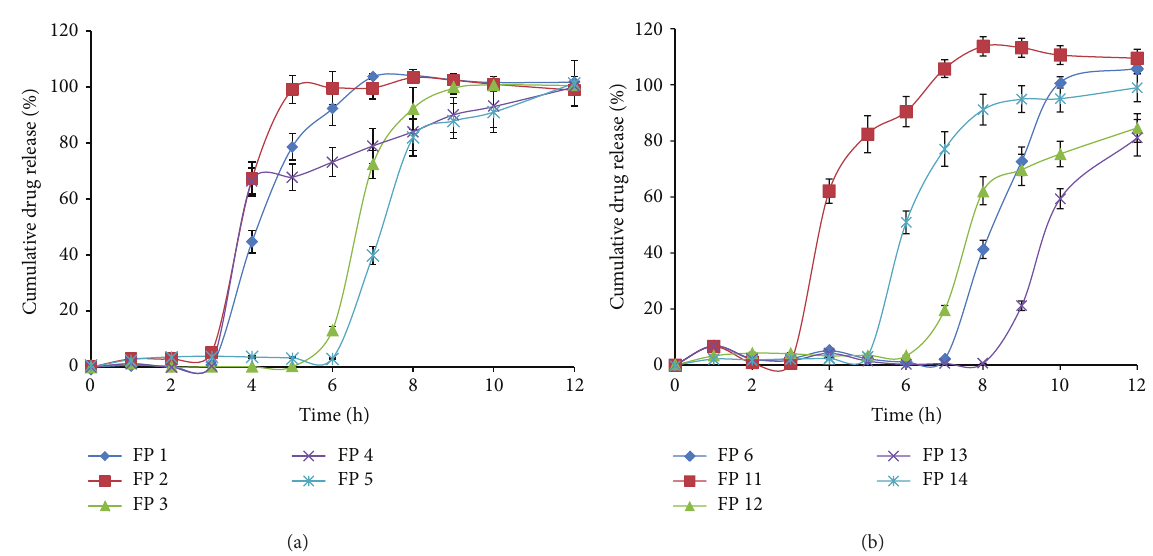
Figure 3: Dissolution profile of various floating pulsatile release formulations.